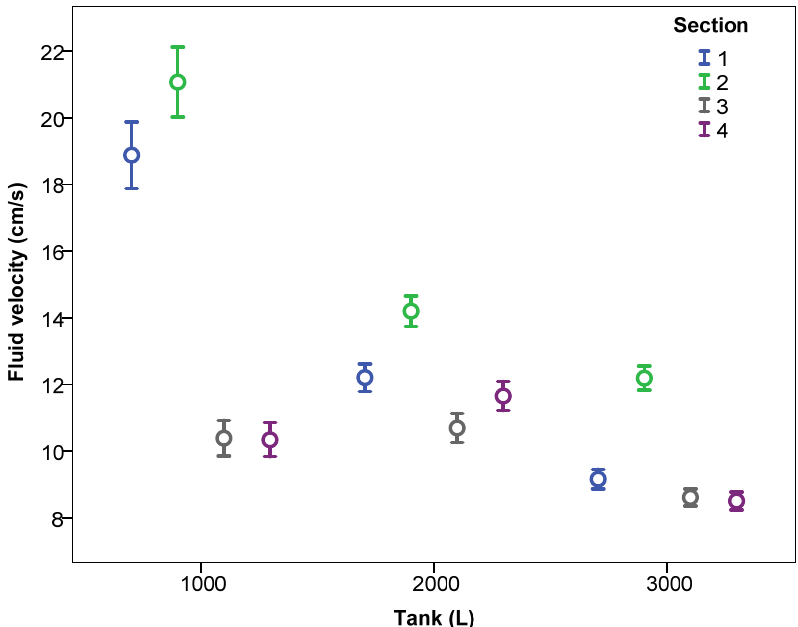
Figure 8. Fluid velocity (mean ± 95% confidence interval) according to the level of water in the tank and the section of the measurement point.